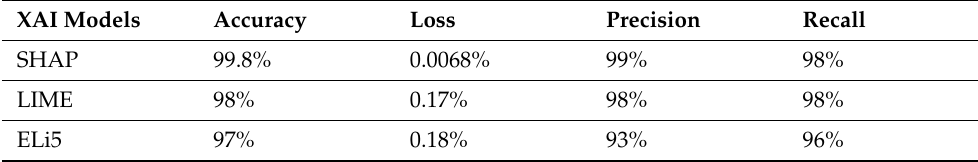
Table 5. Performance analysis of XAI models for 500